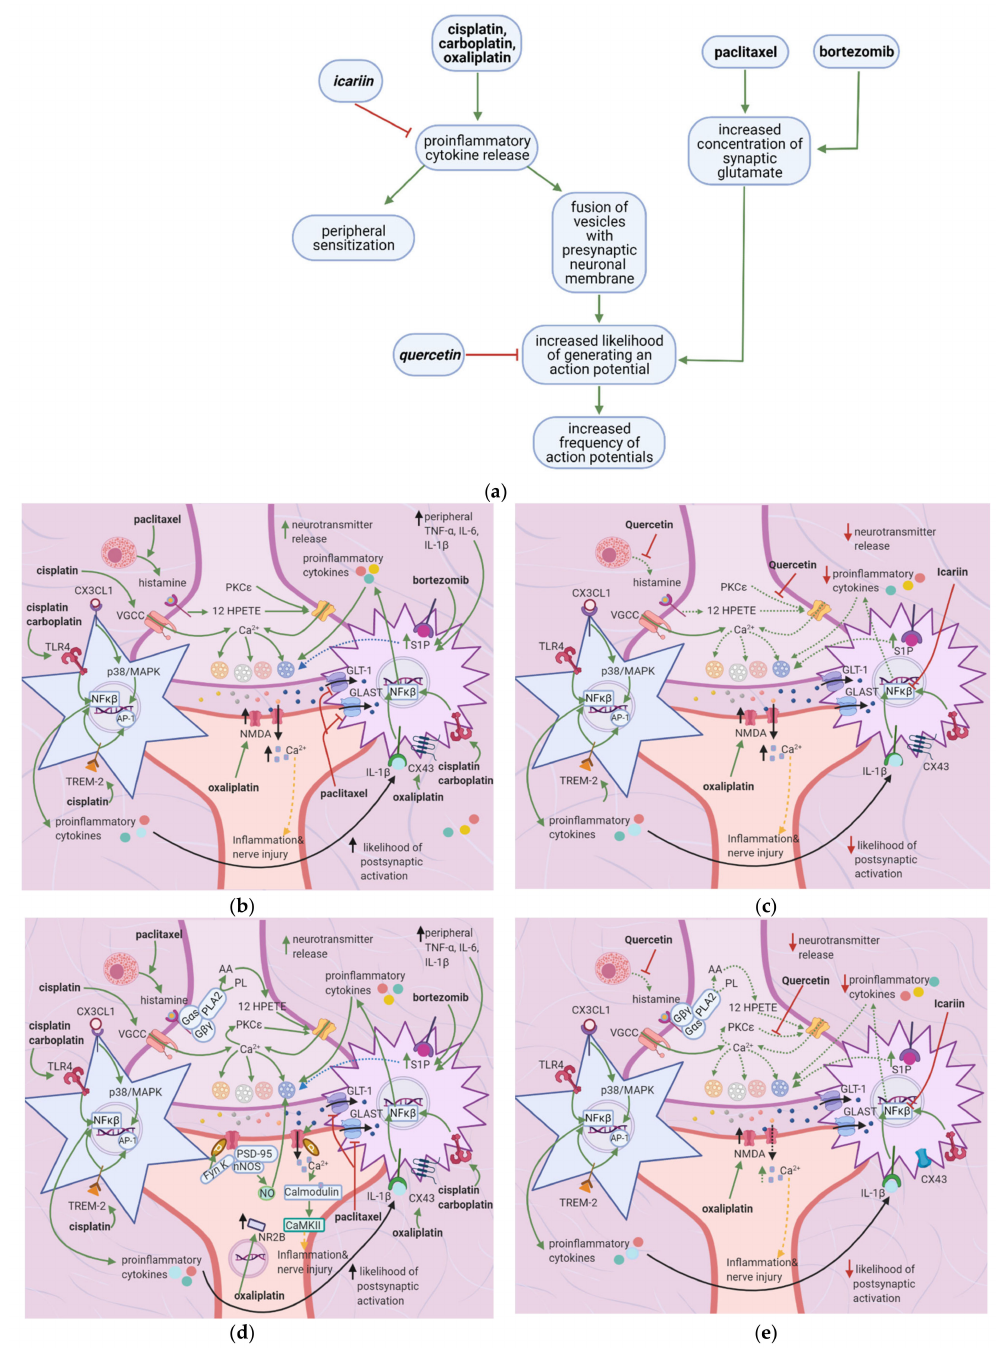
Figure 5. Anticancer drugs modulate signal transmission at a synapse in the dorsal horn spinal cord, and flavonoids counter these effects; ( a ) Simplified Overview of how flavonoids counter the effects of anticancer drugs at the spinal cord dorsal horn. ( b ) Actions of anticancer drugs at the spinal cord dorsal horn. Anticancer drugs increase presynaptic NT release and the likelihood of postsynaptic neuronal activation and activate microglial cells and astrocytes, releasing proinflammatory cytokines. Proinflammatory cytokines increase glutamate release and sensitize primary afferent channels; ( c ) Flavonoids counteract anticancer drugs’ actions at the dorsal horn by inhibiting mast cell degranulation, PKC epsilon translocation, and NF- κ B activation. This decreases the likelihood of postsynaptic action potential generation; ( d ) Anticancer drugs increase intracellular Ca 2+ at the synaptic terminal in DRG neurons via activation of VGCC and histamine release, which leads to TRPV1 sensitization; ( e ) Flavonoids reduce neuropathic pain by inhibiting mast cell degranulation. Thus, histamine release and H1R activation decrease, eventually leading to decreased NT